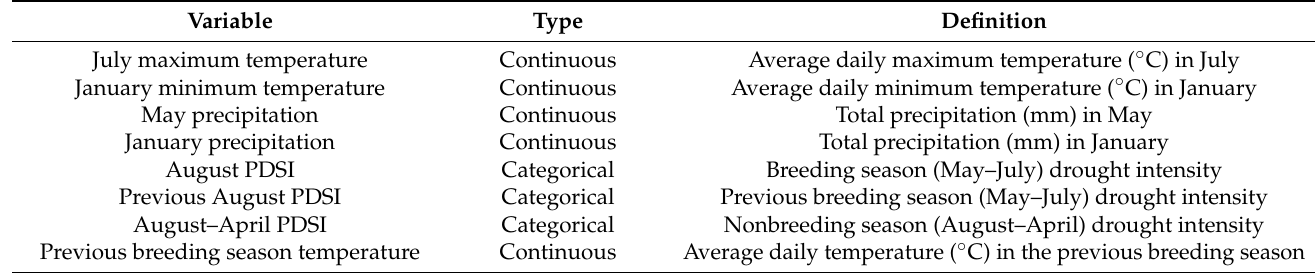
Table 2. Climate parameters tested as predictors of change in Bobolink abundance and/or productivity between 2002 and 2019 on conservation grasslands in Nebraska,